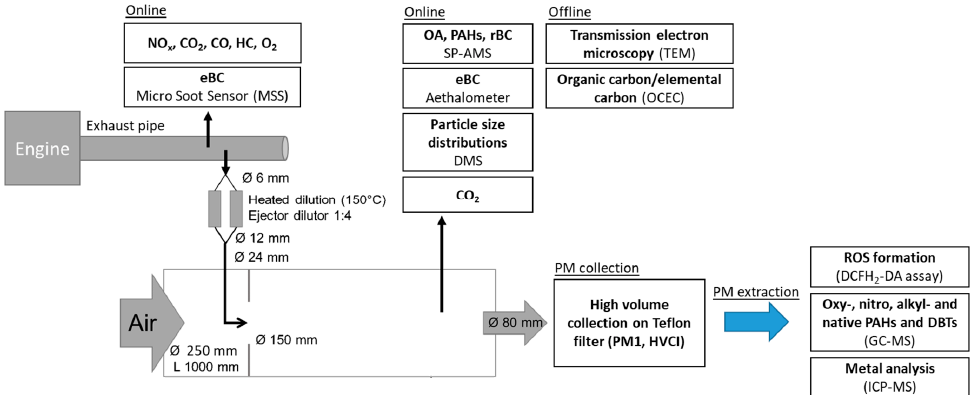
Figure A1. The dilution system (partial dilution flow tunnel) for the PM collection. SP-AMS